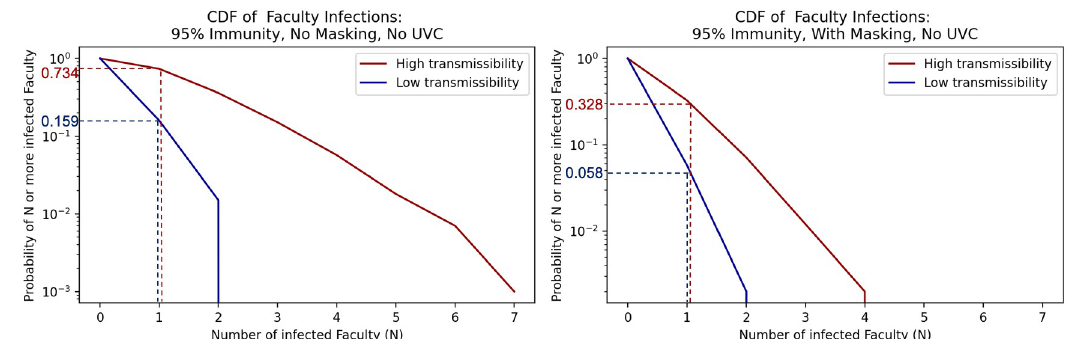
Fig 3. Inverse cumulative density functions for the total number of faculty infected under the different scenarios. Each graph shows the curve of the probability of exceeding a given number of infections.